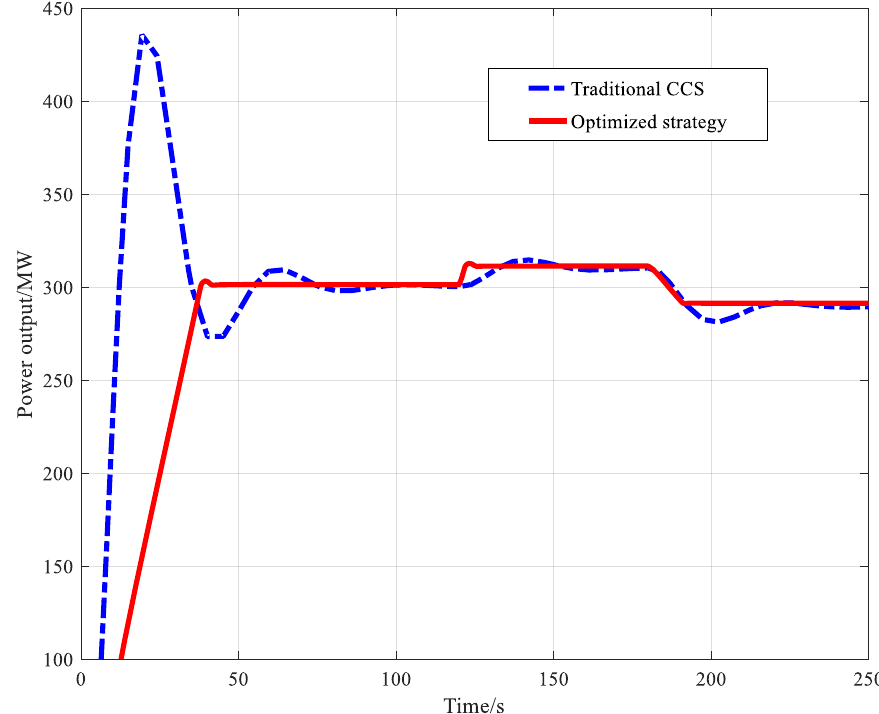
Figure 6. Response curves of power output with power step input by two different strategies.